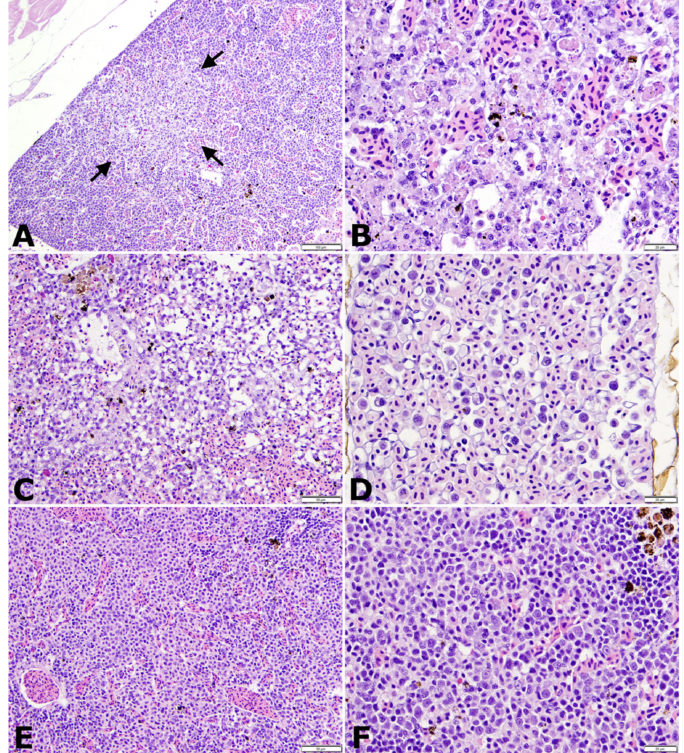
Figure 5. Histologic changes in tilapia fingerlings following intracoelomic injection with 3.4 × 10 6 TCID 50 /fish of novel megalocytivirus on days 2 ( A , B ), 4 ( C , D ), and 12 ( E , F )